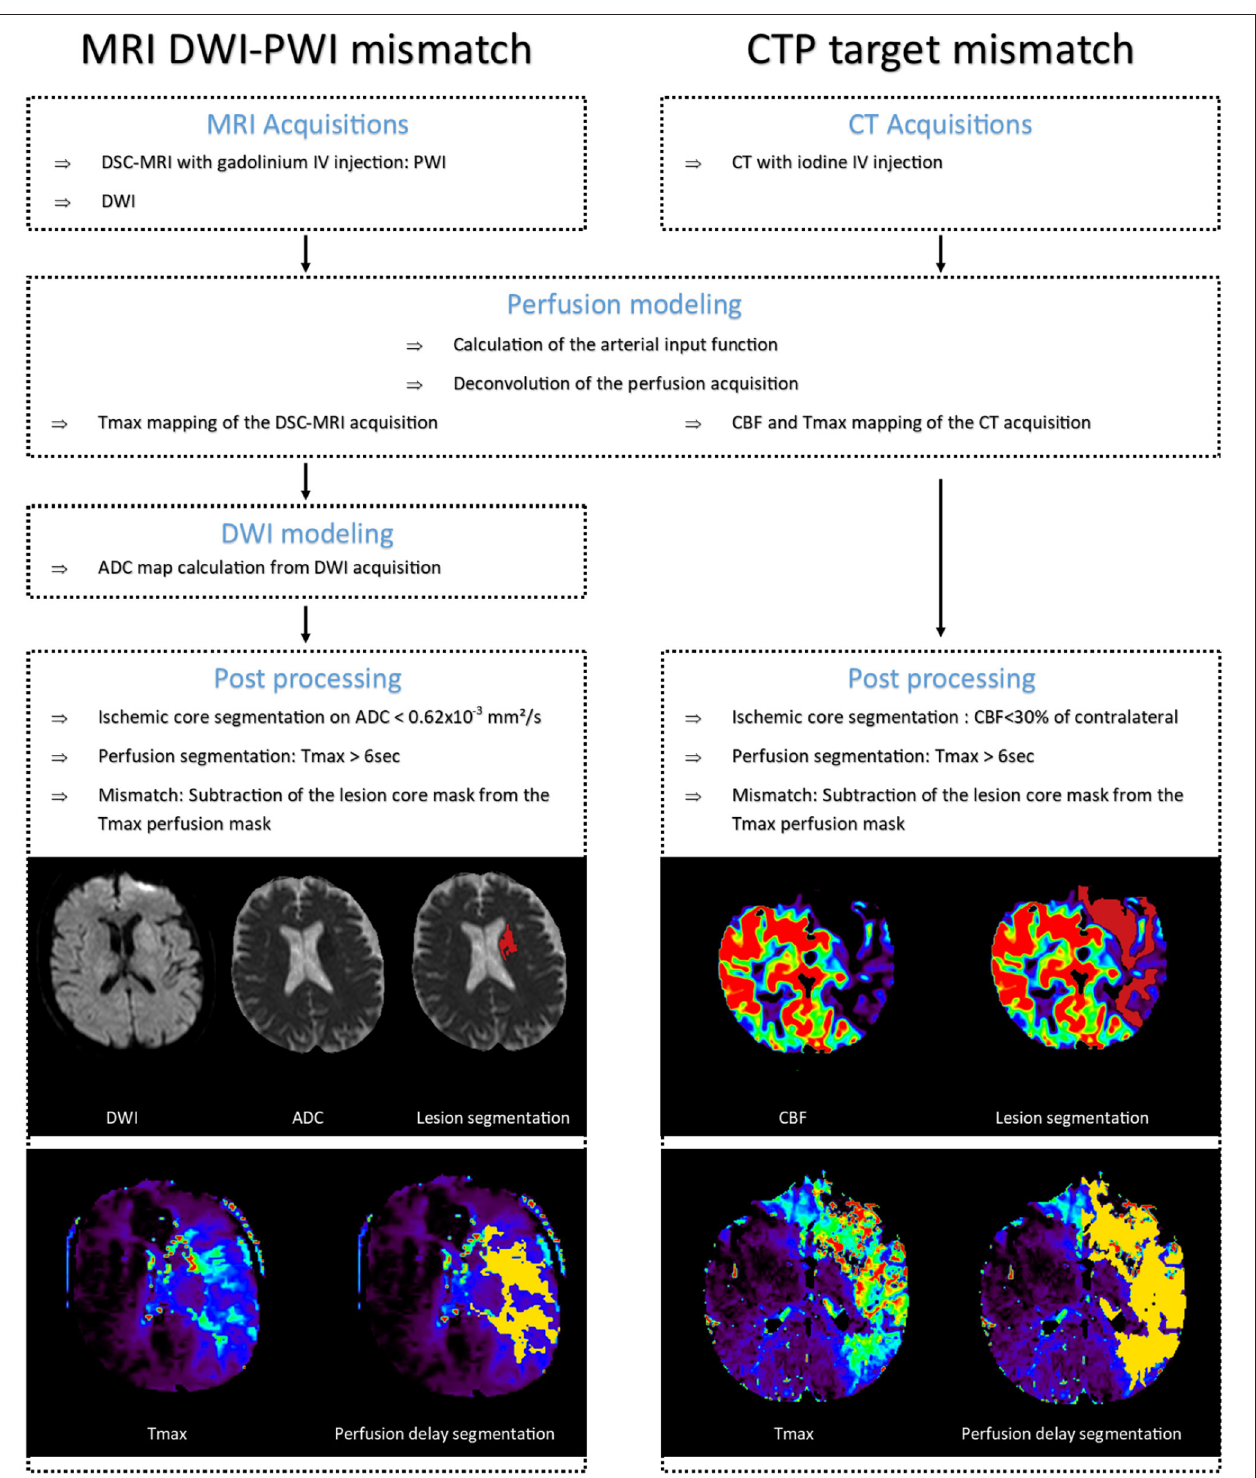
FIGURE 3 | CT and MRI pipelines. In dark red: segmented infarct core. In yellow: segmented perfusion delay on Tmax. Images from Olea Medical. MRI, magnetic resonance imaging; DWI, diffusion weighted imaging; PWI, perfusion weighted imaging; CTP, computed tomography perfusion; DSC, dynamic susceptibility contrast; IV, intravenous bolus; CBF, cerebral blood flow; Tmax, time to maximum of residual function; ADC, apparent diffusion coefficient.